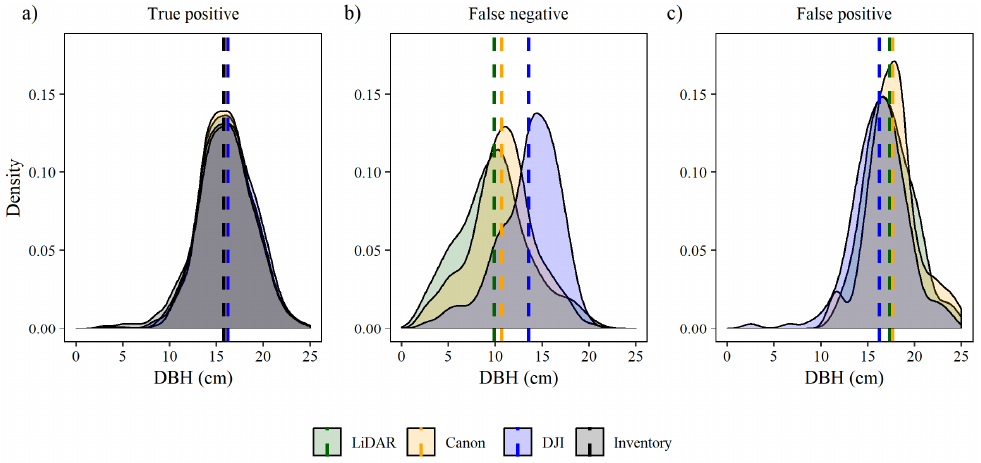
Figure 5. Density plots of tree diameter at breast height (DBH) for false negative (FN), false positive (FP) and true positive (TP) per spacing plots and thinning. Dashed lines are the average of the distribution. 326